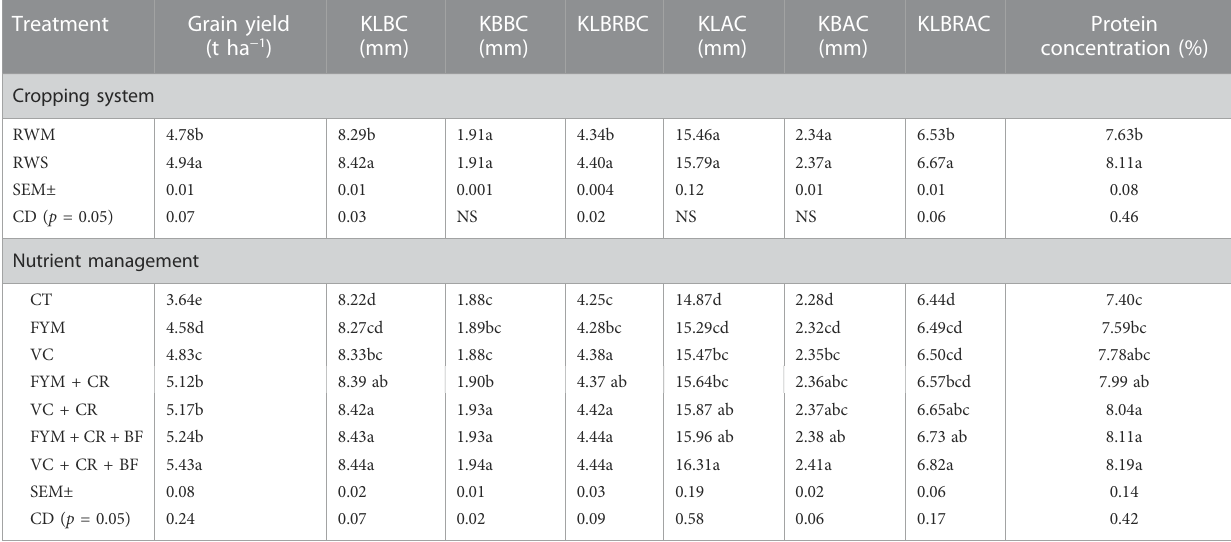
TABLE 2 Long-term effect of cropping systems and organic nutrient management on kernel length, breadth, and protein content of basmati rice.